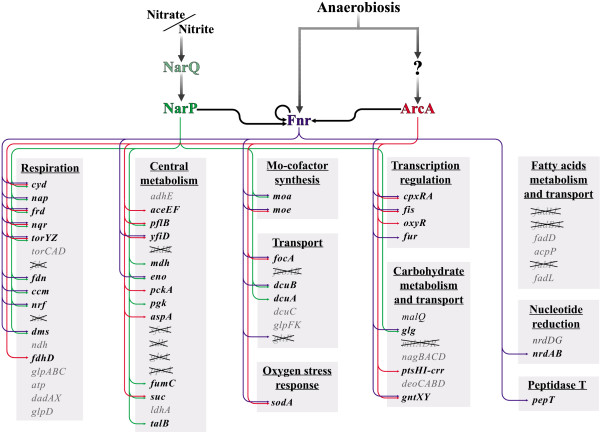
Regulatory interactions in Pasteurellaceae. Notation as in Figure 3.